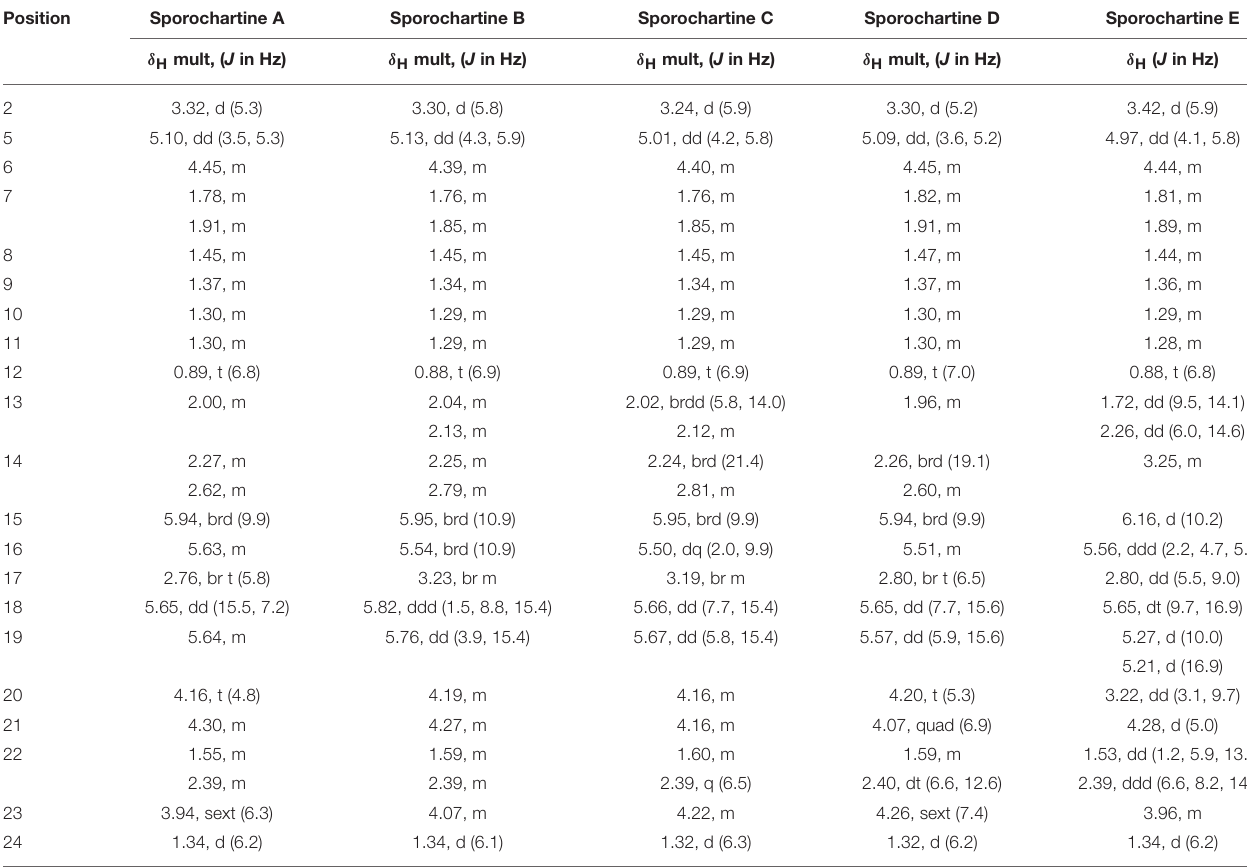
TABLE 1 | 1 H NMR data for sporochartines A–E ( Data acquired in CDCl 3 at 500 MHz).